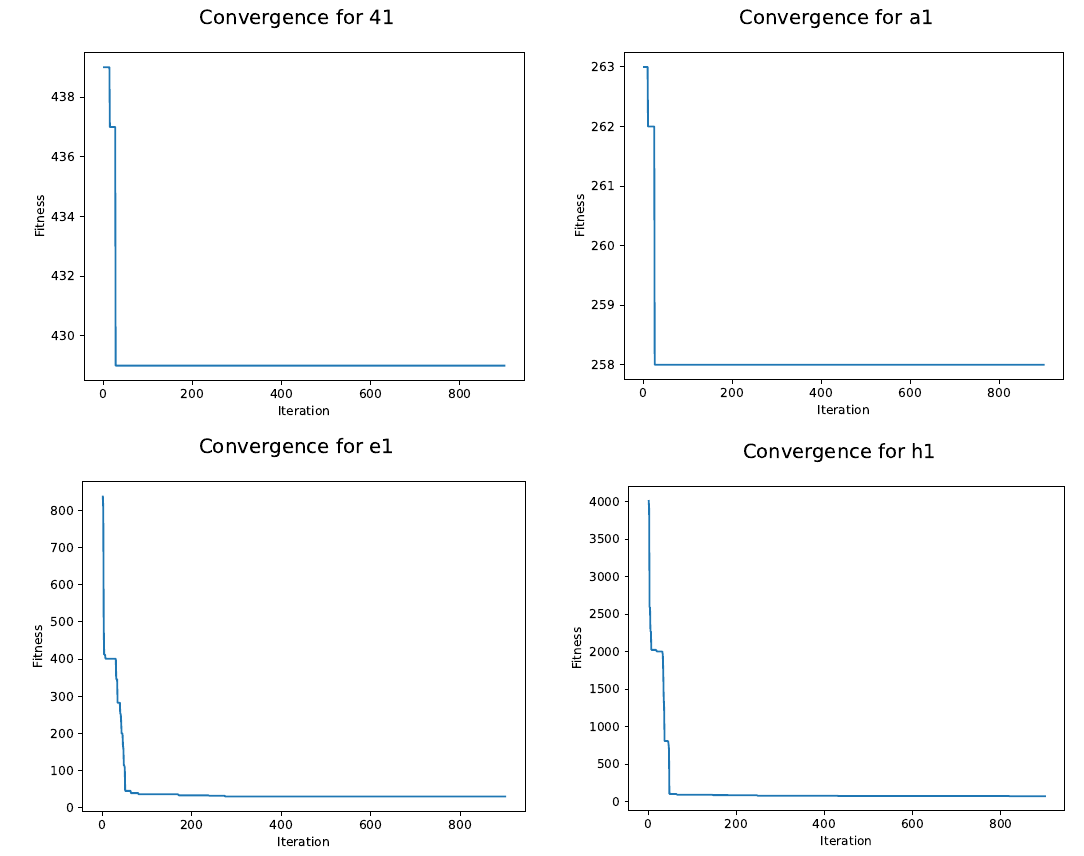
Figure 9. Convergence of PSO: The algorithm shows a premature convergence, with very few improvements after the first 50